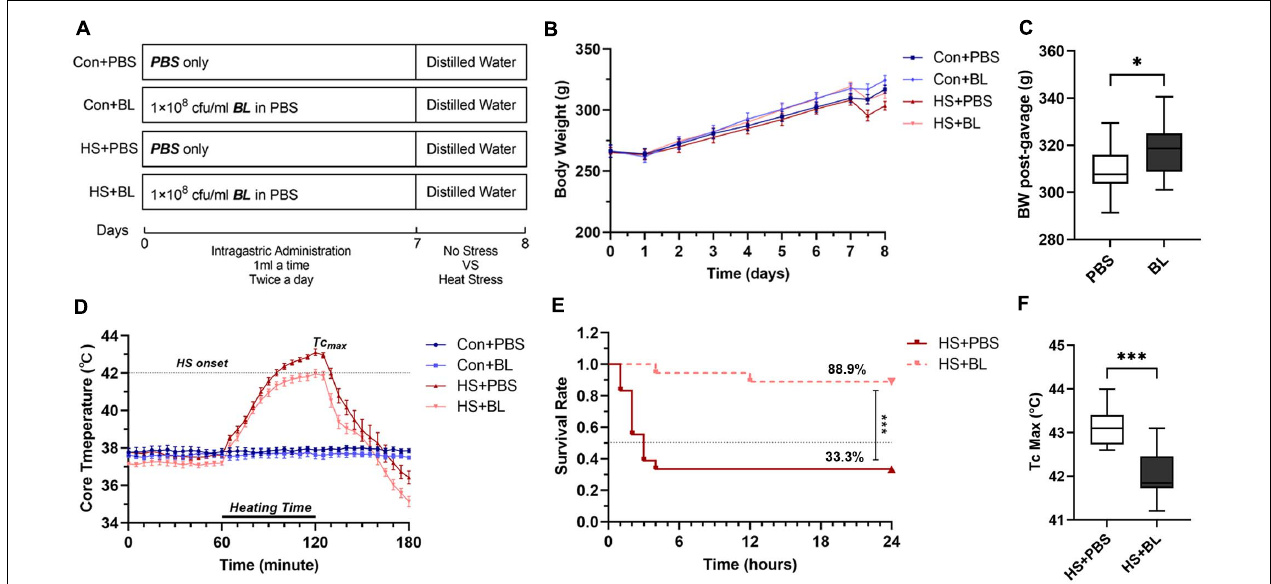
FIGURE 1 | Experimental design and effects of Bacillus licheniformis (BL) on weight, core body temperature (Tc), and survival rate of rats with heat stroke (HS). (A) The BL group was administered 1 × 10 8 CFU BL each twice a day for 7 days. After gavage, the HS model was induced by placing rats in an artificial climate chamber with Ta maintained at 40 ◦ C ± 1 and RH at 65% until the Tc of rats was beyond 42 ◦ C for approximately 60 min. (B) Body weight (BW) changes recorded every day are expressed from the starting gavage day. HS experiments were conducted just after the gavage stage, and pre-heating and post-heating BW were measured at day 7.5. (C) BW of post-gavage in the PBS groups was compared with BW in the BL groups. (D) Core body temperature (Tc, ◦ C) was plotted for every 5 min from 1 h before heating to 1 h after heating. (E) Survival was monitored for 24 h after HS onset. (F) The maximum Tc in HS + PBS was compared with Tc Max in HS + BL. Data of Con + PBS (dark blue line with square), Con + BL (light blue line with circle), HS + PBS (dark red line with upright triangle), and HS + BL (light red line with inverted triangle) are plotted in (B,D,E) . Data in (B,D) are presented as the mean ± SEM of eight rats per group. Data in (C,F) are presented as a box-and-whisker plot of eight rats per group. Eighteen rats in each HS group were used for the survival study. ∗ P < 0.05, ∗∗∗ P <